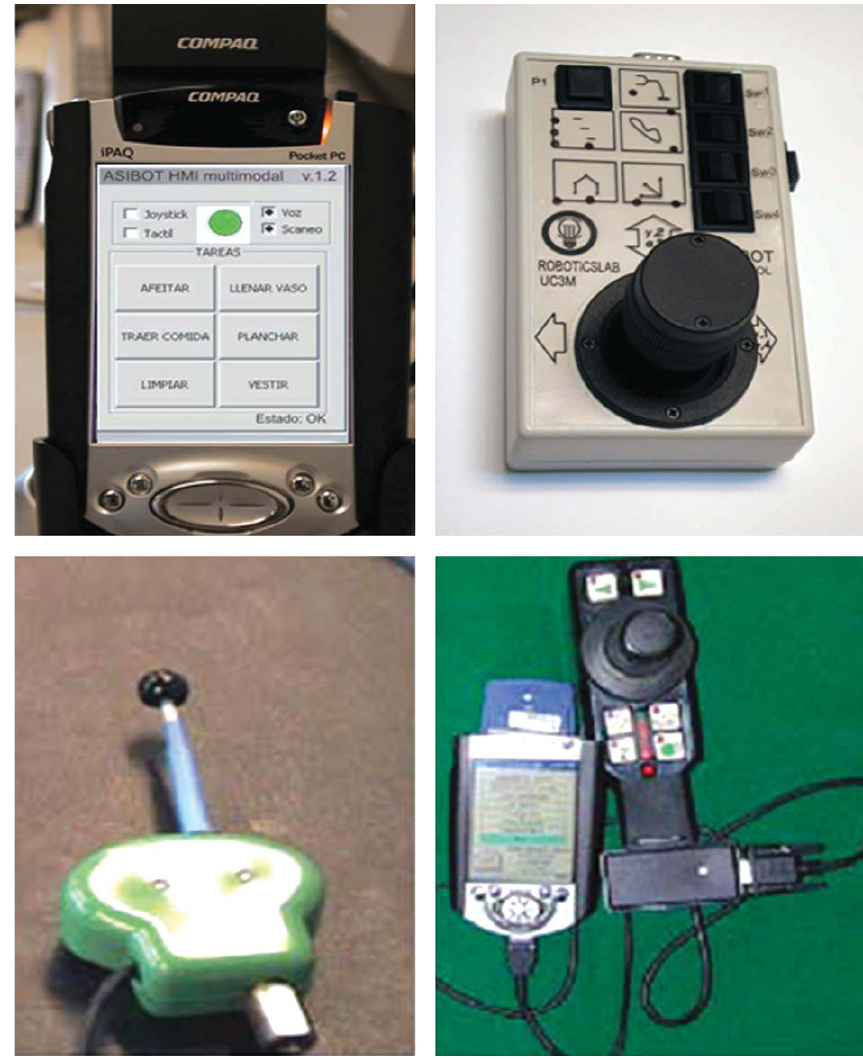
Fig. 5. PDA screen details and access-granted